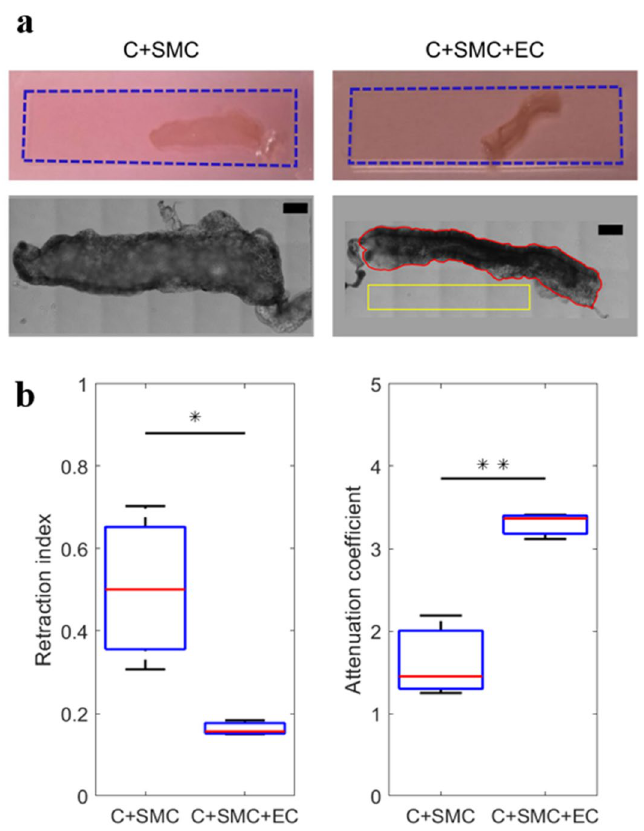
Figure 2. ( a ) Examples of contracted C + SMC and C + SMC + EC samples. Top row: representative photographs after 3 days of culture. The dashed blue rectangle represents the initial contour of the sample at day 0. Bottom row: zoomed bright-field images of the same samples. Scale bar corresponds to 1.5 mm. As an example, the area occupied by the considered C + SMC + EC contracted sample (projected on the image plane) at day 3, is delimited by the continuous red line. The retraction index is obtained by calculating the ratio between the surface delimited by the continuous red line and that occupied by the sample without contraction at day 0 (delimited by the dashed blue rectangle). The attenuation coefficient is obtained by calculating the ratio between the average transmitted light intensity in the area inside the continuous red line and that of the background inside the continuous yellow rectangle. ( b ) Statistical comparison of the retraction index and the attenuation coefficient for C + SMC and C + SMC + EC samples. Three samples were analyzed for each considered condition. In the box plots, the red lines represent the median values, while the whiskers extend to the most extreme data points. * p < 0.050. ** p <